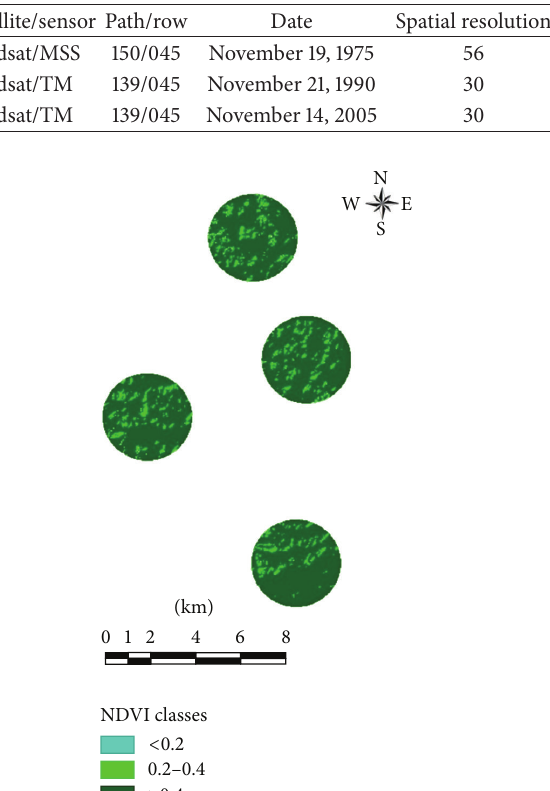
Figure 2: Vegetation density map in terms of NDVI classes in 5 km buffer area surrounding the highest elevation points for 1975.